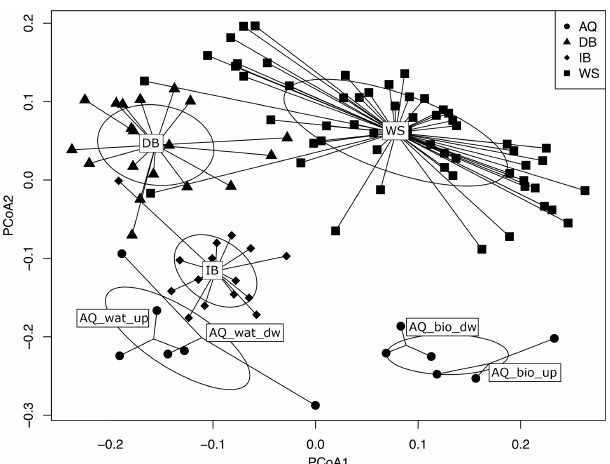
Figure 3. PCoA analysis of weighted UniFrac dissimilarities be- tween the V5-V6 16S rRNA gene OTU profiles of the watershed (WS) runoff waters, urban sediments and soils from the connected detention (DB) and infiltration (IB) basins, and waters (AQ_wat) and biofilms (AQ_bio) from the connected aquifer. See Fig. 1 for a description of the experimental design. Ellipses are representative of the variance observed (standard error) between the ordinations of a group of samples. PERMANOVA tests confirmed the signifi- cance ( p< 0 . 001) of the groupings. The proportion of the eigenvalue per axis over the sum of all eigenvalues was 25.0% for PCoA1 and 17.6% for PCoA2. The subsampled V5-V6 16S rRNA gene dataset was used for the